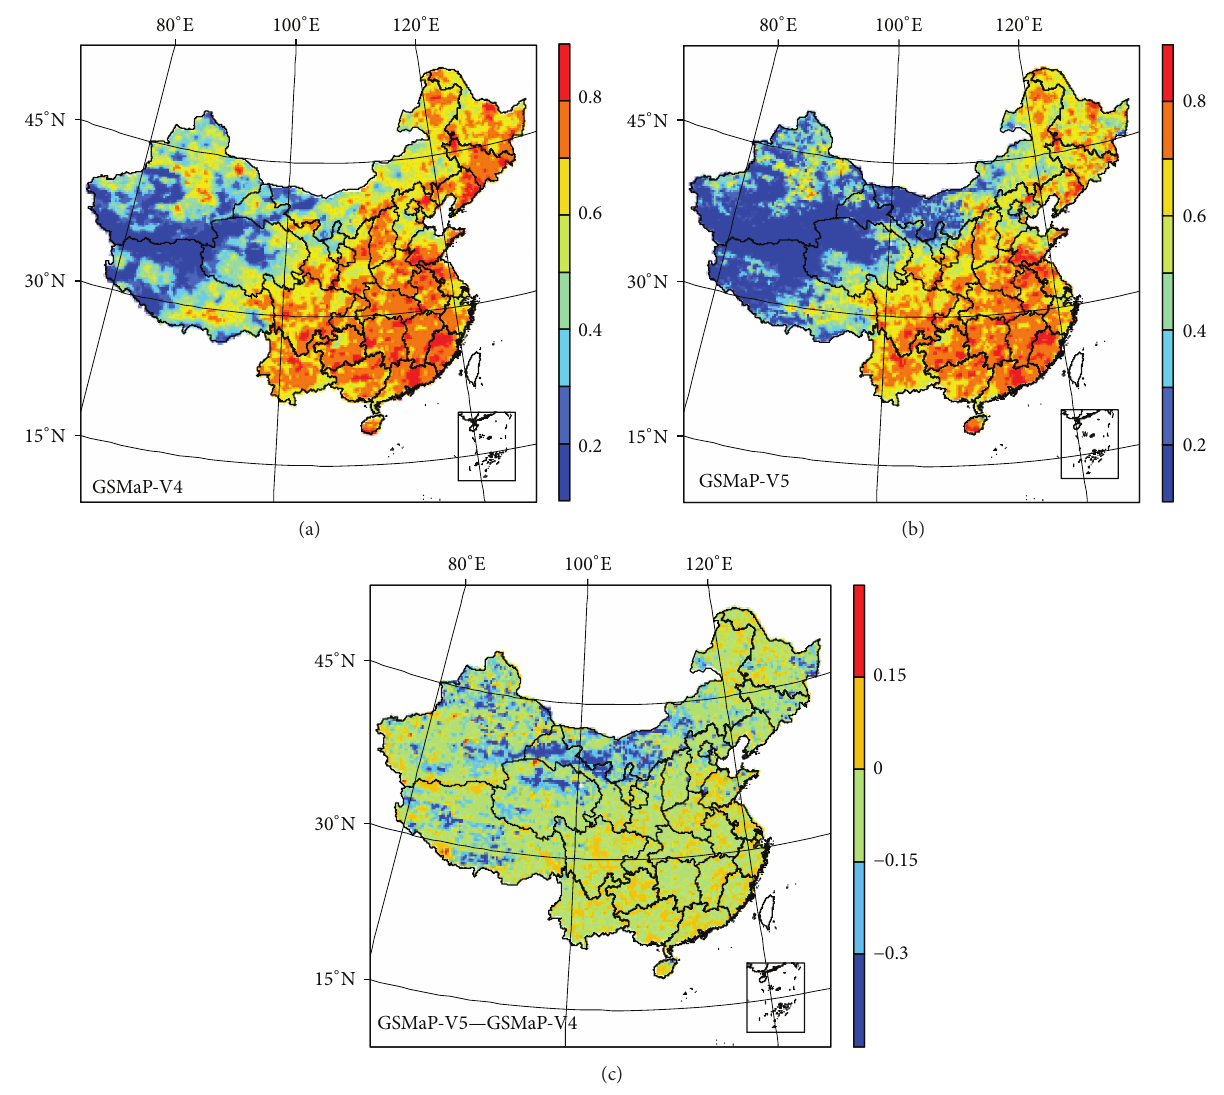
Figure 6: Distribution of correlation coefficient for GSMaP products over the Chinese Mainland from 2003 to 2006. (a) GSMaP-V4, (b) GSMaP-V5, and (c) difference between GSMaP-V4 and